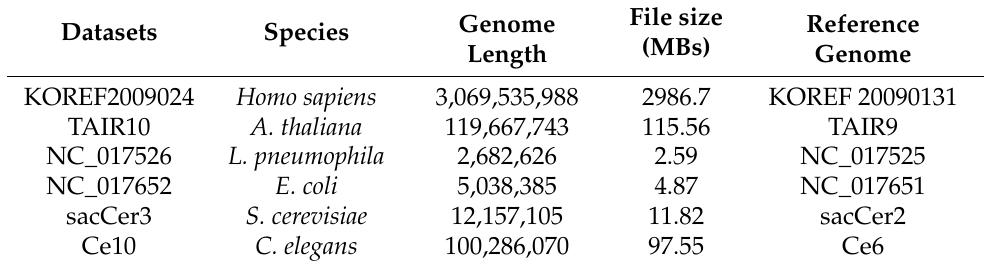
Table 4. Genome datasets used for